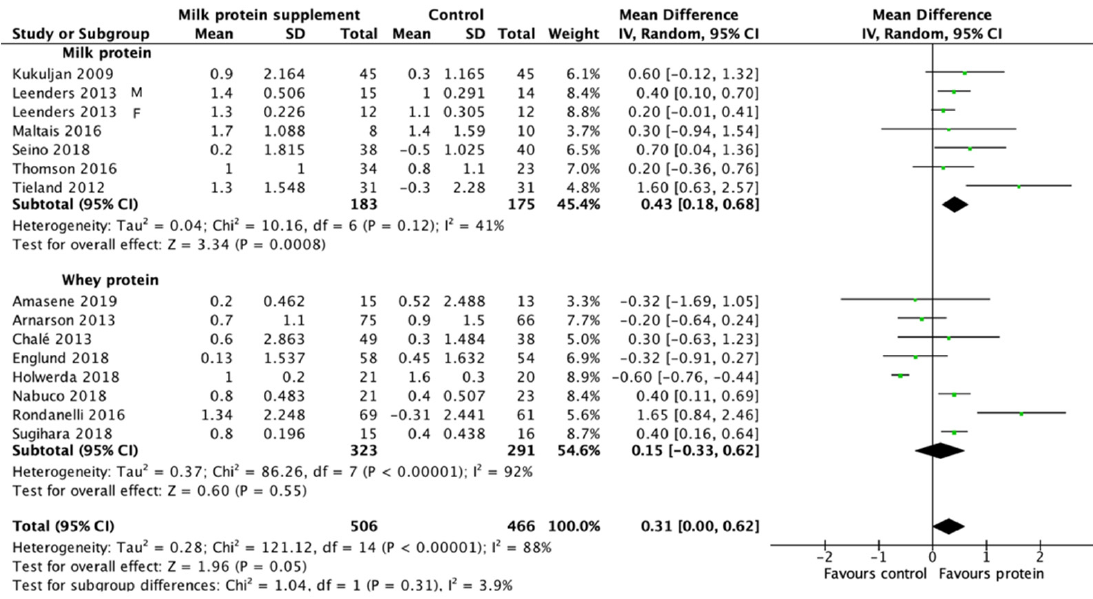
Figure 5. Forest plot for the differences in RT-induced LBM/FFM gain between consuming milk-based protein supplements and control supplements considering the subgroup analysis of protein supplementation dosage.